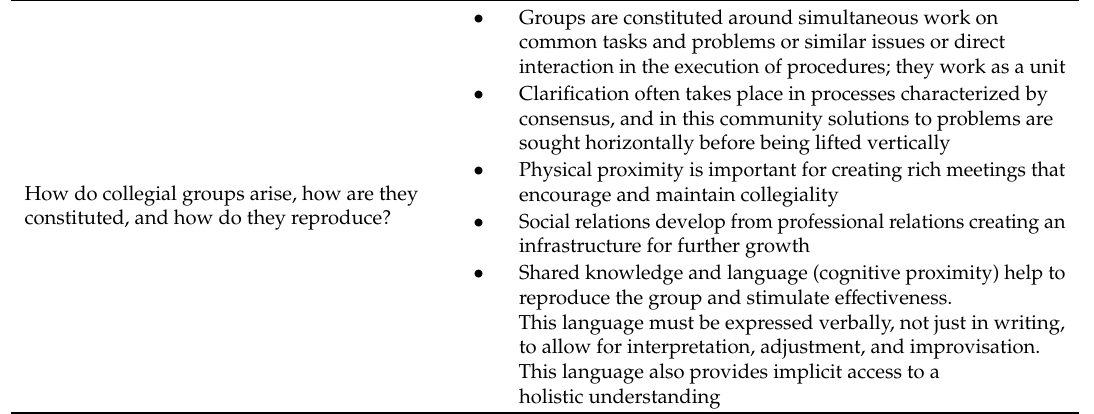
Table 9. Collegial groups as an organizational framework for coordination in patient